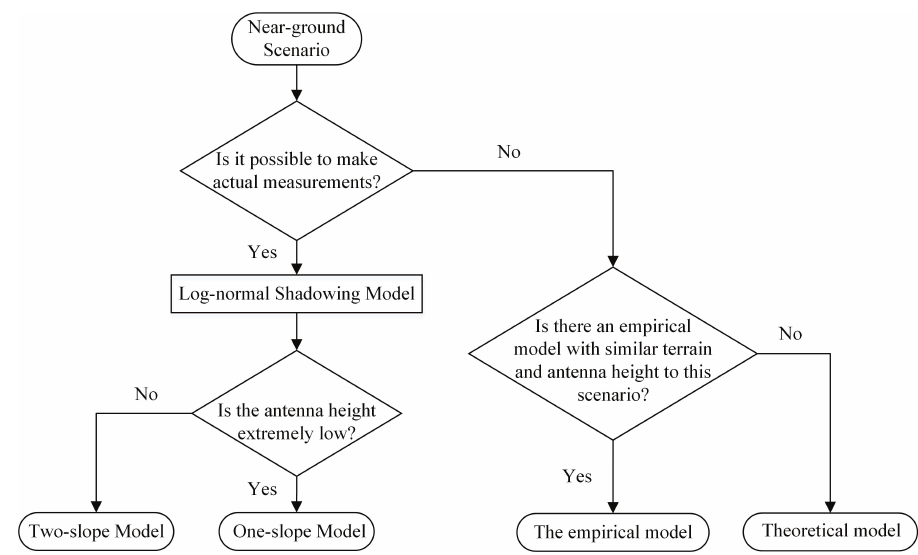
Figure 9. Schematic diagram of the propagation model selection